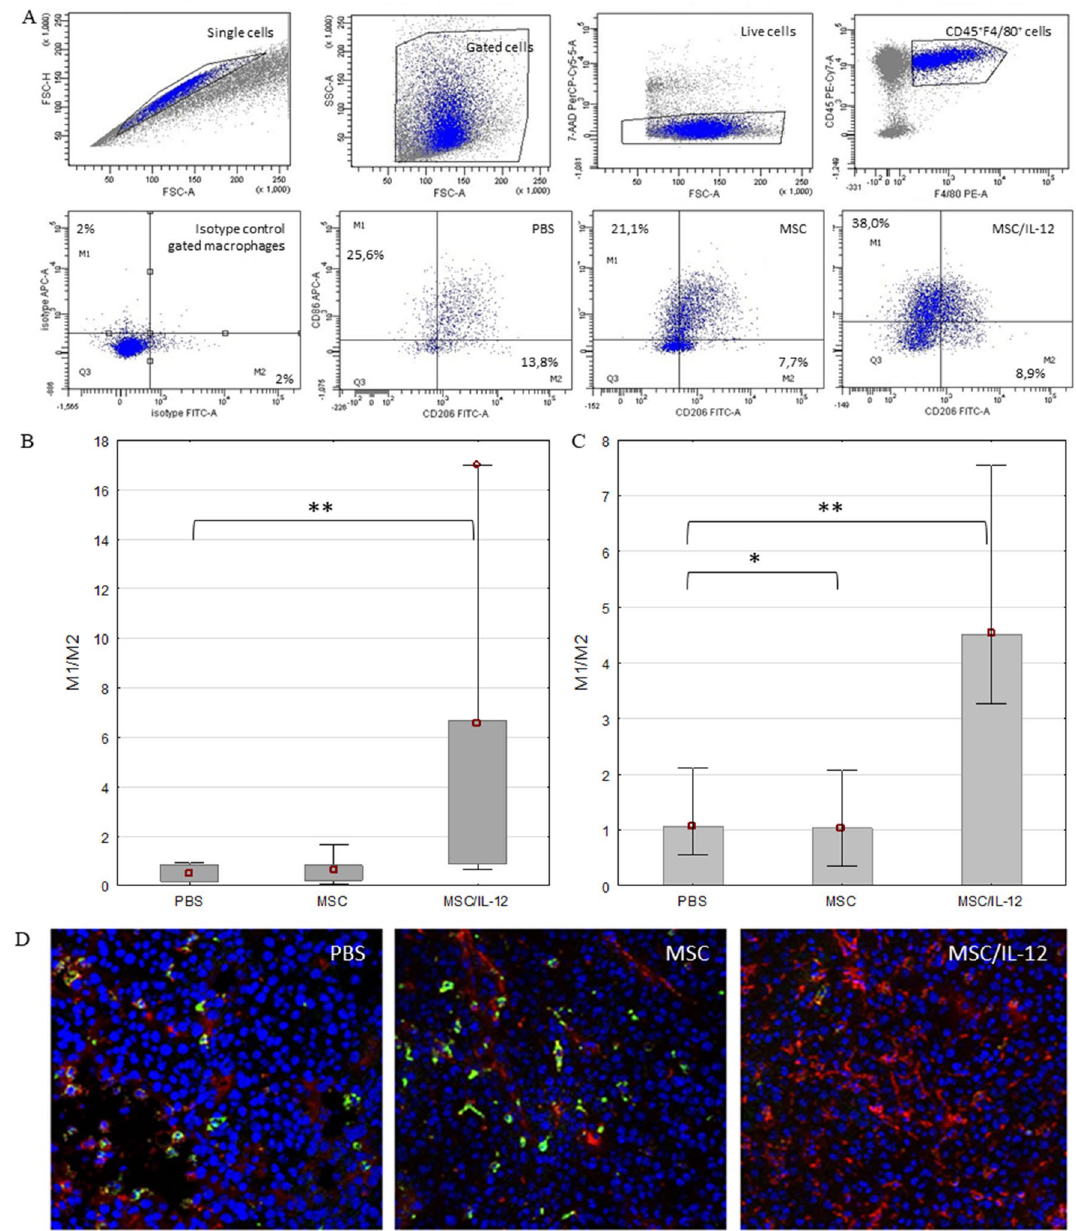
Figure 12. The M1/M2 ratio of macrophages in tumors after the therapy. Flow cytometry gating strategy with representative flow graphs. Macrophages (7-AAD - CD45 + F4/80 + ) from each tumor were gated to appropriate isotype control ( A ). Macrophages isolated from B16-F10 tumors [per 100 mg of tissue, n = 5] collected 8 days after the cells administrations and analysed by flow cytometry. In tumors collected from animals treated with MSC/IL-12 cells, the ratio of M1/M2 macrophages is significantly higher comparing to controls ( B ). Immunohistochemical analyses of frozen sections from tumors (n = 5) collected 8 days after the cells administration. The ratio of M1/M2 macrophages in tumors collected from mice treated with MSC/IL-12 is fourfold higher comparing to controls ( C ). Representative images of tumor sections from mice treated with PBS, unmodified MSC or MSC/IL-12, (F4/80 + , AlexaFluor594—red, CD206 + , FITC—green) (D). *p < 0.05, **p <